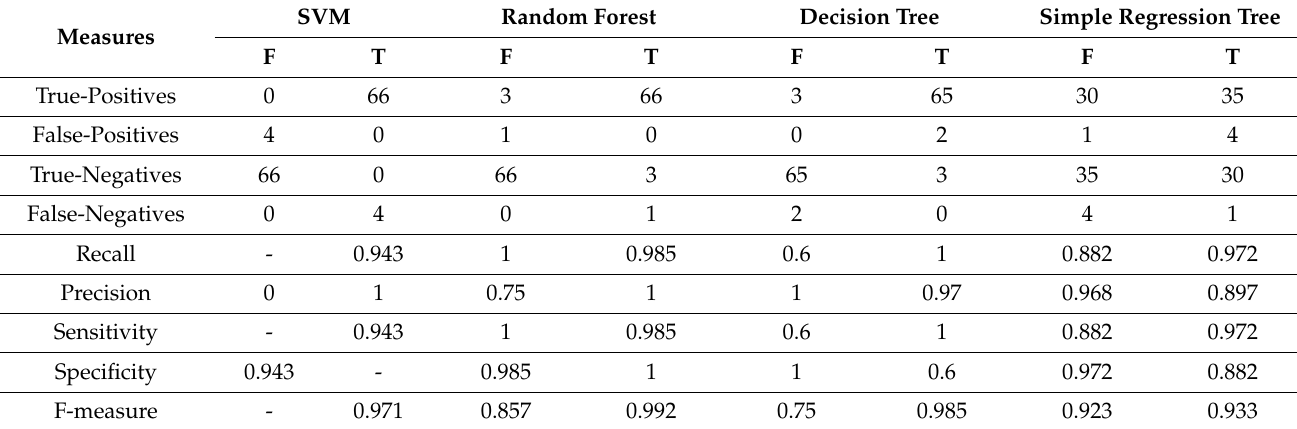
Table 5. Testing measures.